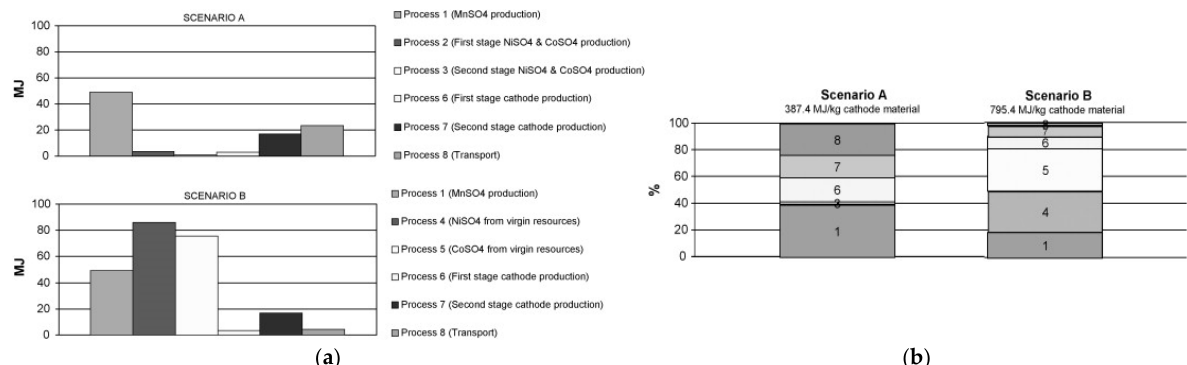
Figure 3. ( a ) Inputs (exergy, MJ) necessary and allocated for the production chain of 1 kg Li-ion battery cathode material. Scenario A: starting from battery waste with Ni and Co recovery. Scenario B: from virgin resources; ( b ) Contribution (in%) to the total natural resource consumption as a function of the involved processes, including their supply chains. Reprinted from Resources, Conservation and Recycling, Vol. 54, Dewulf et al. [18], Recycling rechargeable lithium-ion batteries: Critical analysis of natural resource savings, no. 4, pp. 229–234, Copyright (2022), with permission from Elsevier.